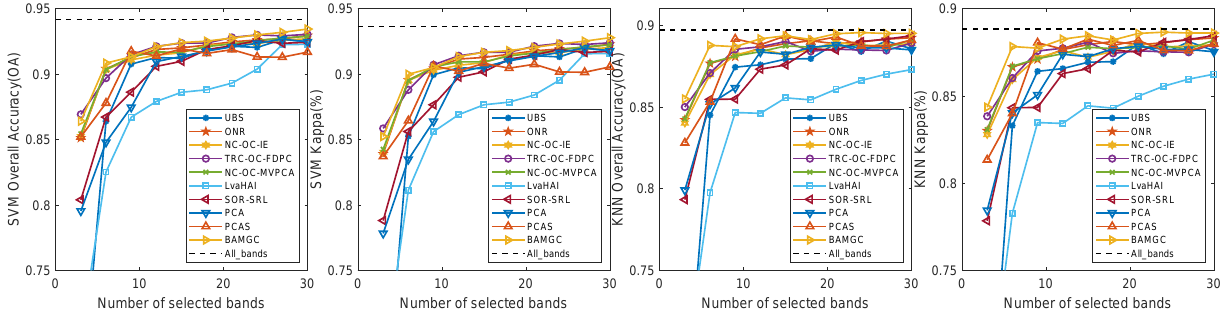
Figure 6. The comparison of OA and κ produced by SVM and KNN on the Salinas